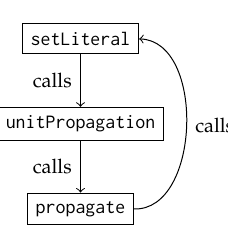
Figure 4. Flowchart of the method setLiteral